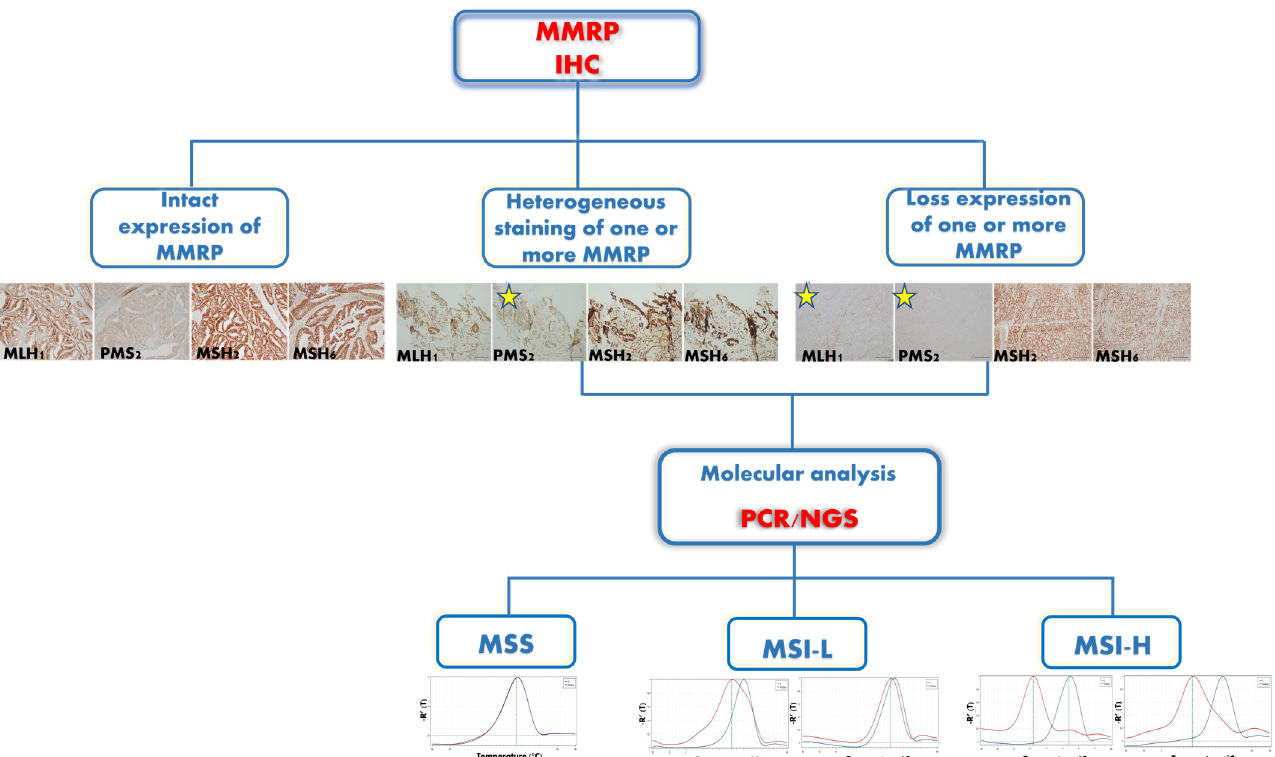
Figure 2. The diagnostic algorithm of MSI status. MMRP IHC is used as a screening test: the intact expression of all four MMRPs is a conclusive result of the MSS status (original magnification 10 × ); the heterogeneous staining of one or more MMRPs needs an additional molecular assay (original magnification 10 × ); and the loss of one or more MMRPs needs a molecular assay (original magnifica- tion 10 × ). The molecular analysis performed through PCR and/or NGS leads to a conclusive result in cases with IHC equivocal staining. MMRP: mismatch repair proteins; IHC: